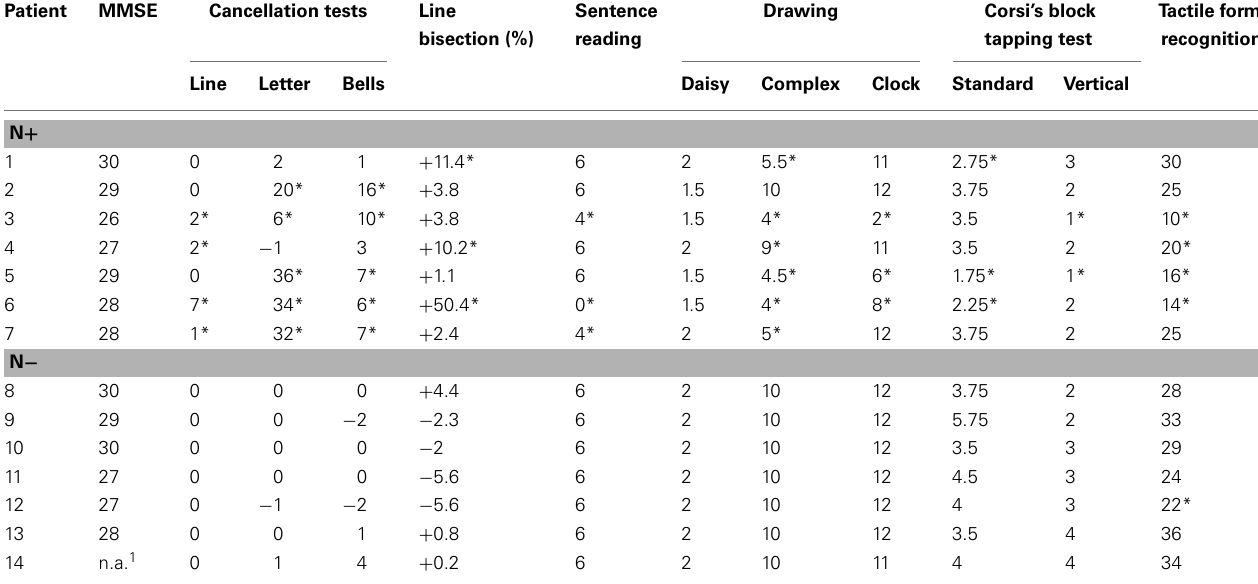
Table 2 | Clinical data of 14 right-brain-damaged patients with (N + ) and without (N − ) USN. Patient MMSE Drawing Corsi’s block